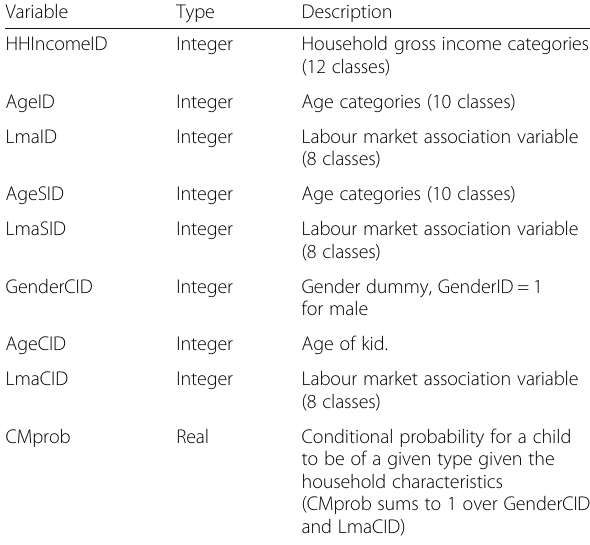
Table 11 Marginal probabilities of having a specific type of kids in certain types of household